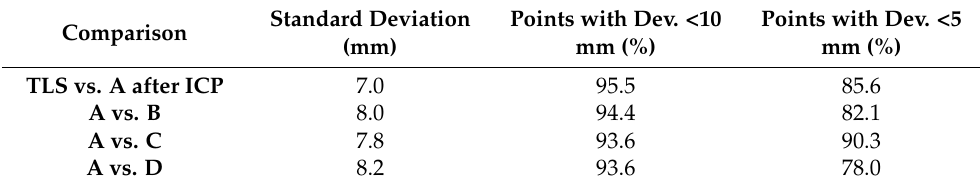
Table 5. Statistics from the comparison of all